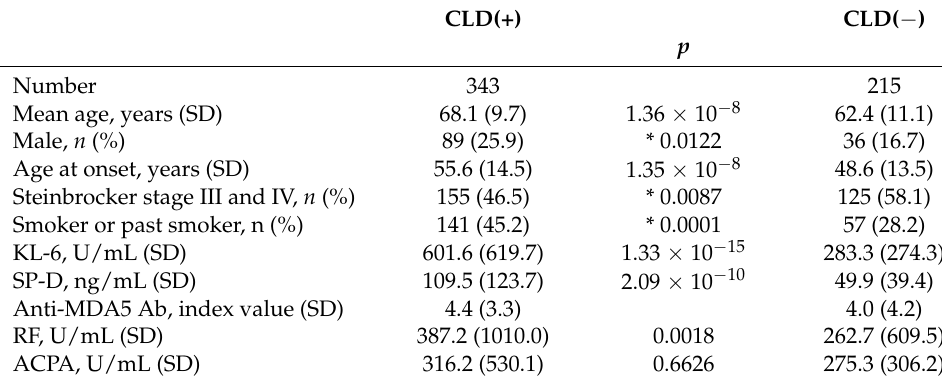
Table 2. Characteristics and anti-MDA5 Ab in RA patients with or without